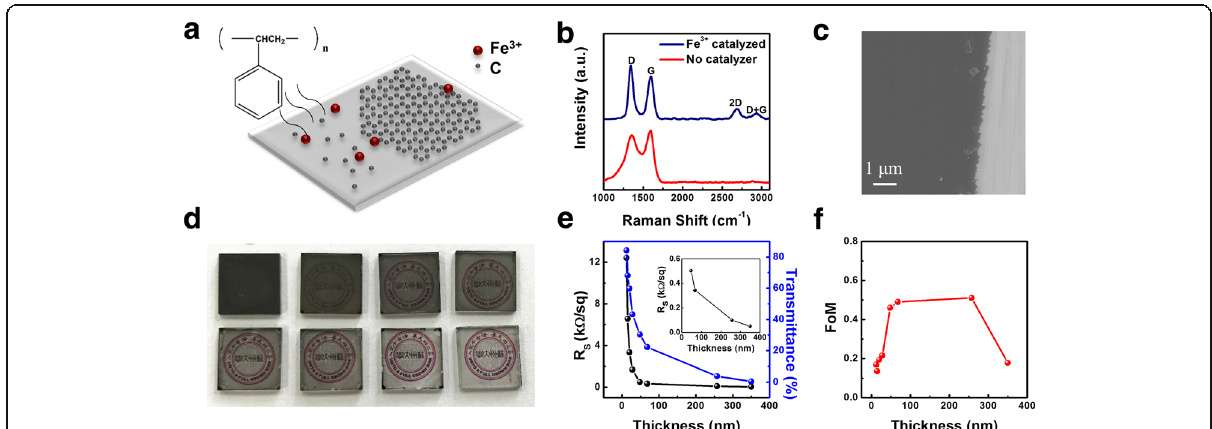
Fig. 1 Deposition and characterization of MGF. a Schematic illustration of CVD deposition of MGF with Fe 3+ as catalyzer. b Raman spectrum of graphene film with and without catalyzer (at 633 nm excitation wavelength). c SEM image of MGF. d Photos of MGF deposited on quartz substrate with different thickness. e Comparison of the sheet resistance and transmittance of MGF with different thickness. f Comparison of the thickness and FoM of MGF obtained in this